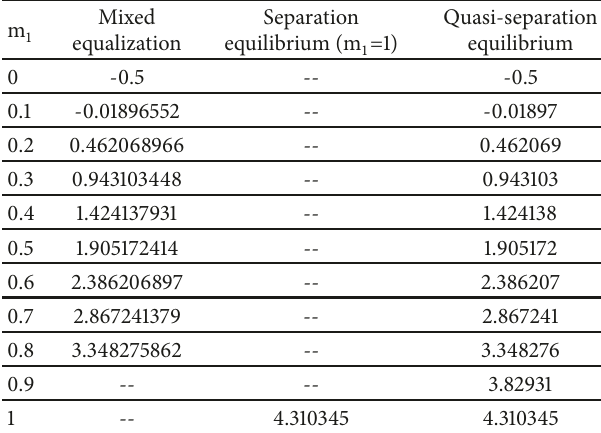
Table 7: Simulation of returns of bank.